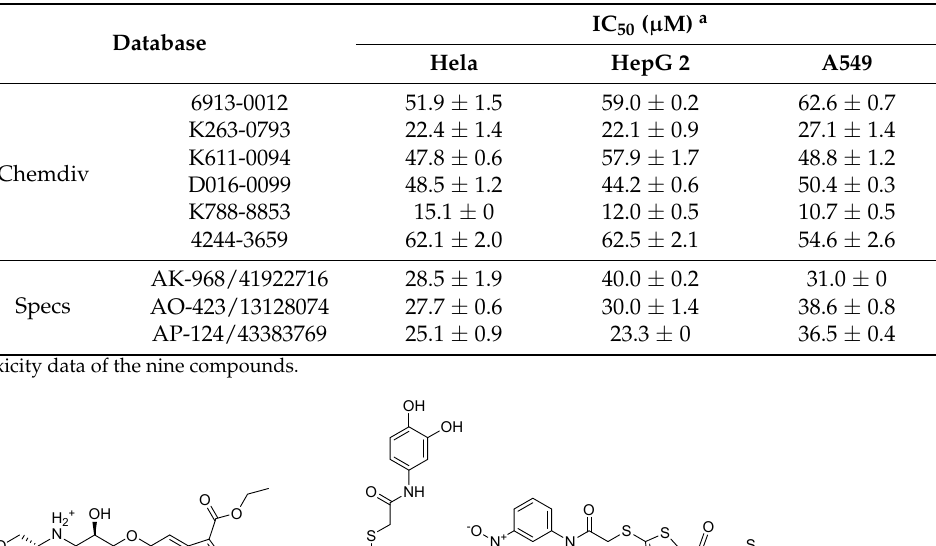
Table 2. Toxicity for each compound predicted by docking.